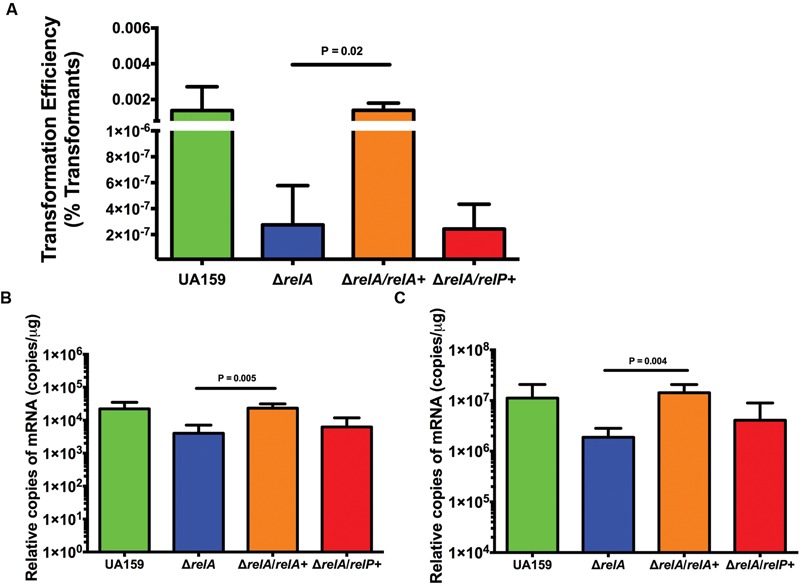
Complementation of the ΔrelA mutant with relA restores competence phenotypes. (A) Transformation efficiency between strains UA159 (green bar), ΔrelA (blue bar), relA+/ΔrelA (relA mutant complemented with relA; orange bar), and relP+/ΔrelA (relA mutant complemented with the gene for the small SAS RelP; red bar) in FMC medium with addition of 2 μM sXIP. sXIP and transforming DNA plasmid pDL278 (SpR) were added when OD600
nm reached 0.2. Serial dilutions of cultures were plated on BHI agar. Transformation efficiency was calculated by dividing the number of transformants by the total number of viable bacteria, then multiplying by 100. Data represent the average of three individual experiments conducted in triplicate. Statistical analysis was performed by Student’s t-test. (B,C) Measurement of mRNA by qRT-PCR of comR
(B) or comX
(C) in UA159 (green bars), ΔrelA (blue bars), relA+/ΔrelA (orange bars), and relP+/ΔrelA (red bars) after addition of 2 μM sXIP. sXIP was added when OD600
nm reached 0.2. After 1 h of incubation, cells were harvested by centrifugation, RNA isolated, and qRT-PCR performed. Gene expression was normalized to 16S rRNA expression. Data are derived from three biological replicates assayed in triplicate. Statistical analysis was performed by Student’s t-test.